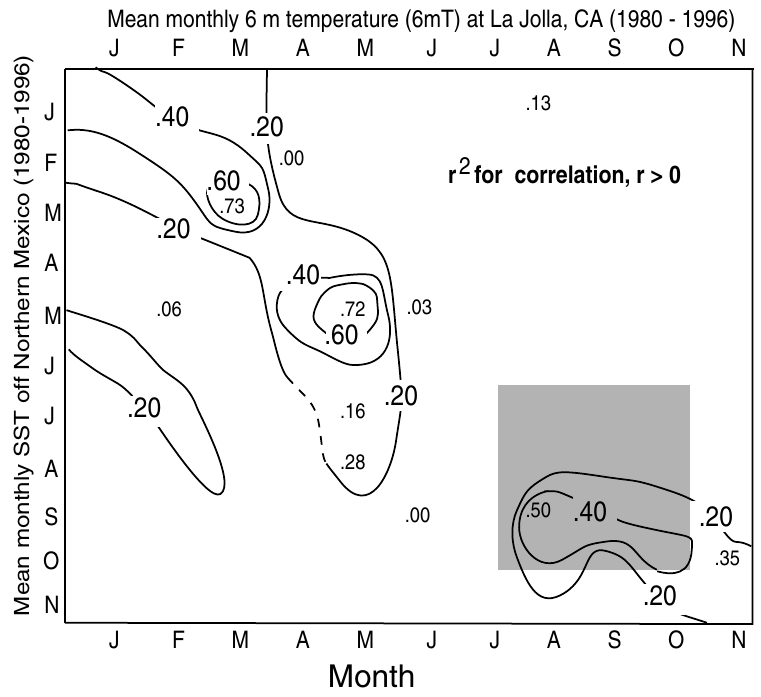
F IG . 4. – Contours of the time-dependent relationship between monthly mean temperature at the La Jolla, California shore station and month- ly mean temperature from a rectangle with the 29°N 116°W to 31°N 117°W diagonal for 1980-1996 (Fig. 1). Squared correlation coefficients (r 2 ) are contoured at 0.20 intervals. r 2 values are used rather than r values to simplify plotting and accentuate gradients. The July - October CPFV fishing season, when more than 80% of the fish are landed, is shaded. Correlation is positive for all r 2 > 0.02. For r 2 > 0.3, p <